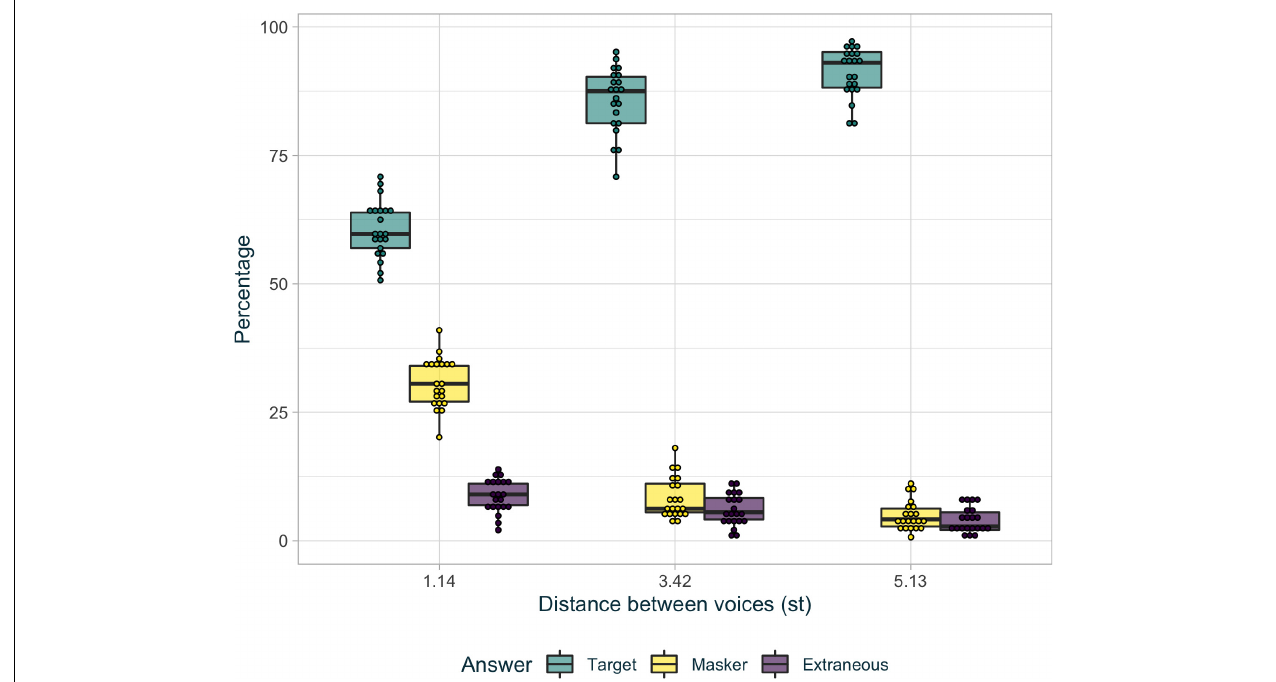
FIGURE 3 | Percentage for target answers (in green), masker answers (in light yellow), and extraneous answers (in dark purple) in each level of difficulty. The points represent each identified keywords percentage for every participant in each condition. The hinges of the boxplot represent the first and the third quartile. The middle of the boxplot is the median. The whiskers extend up to 1.5 times the interquartile